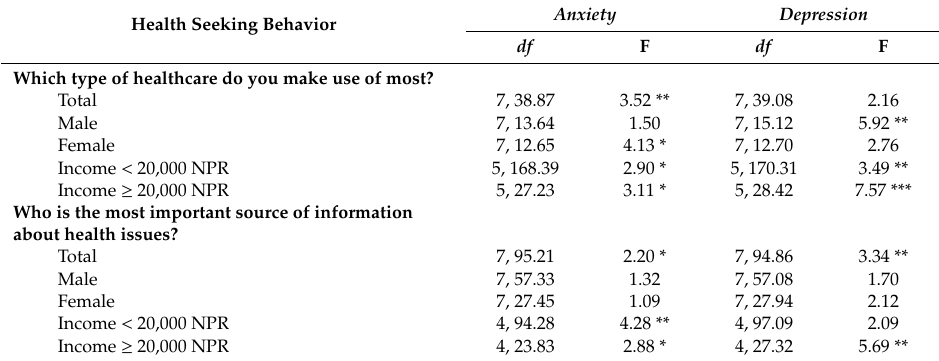
Table 3. ANOVA Results: between group di ff erences on gender and